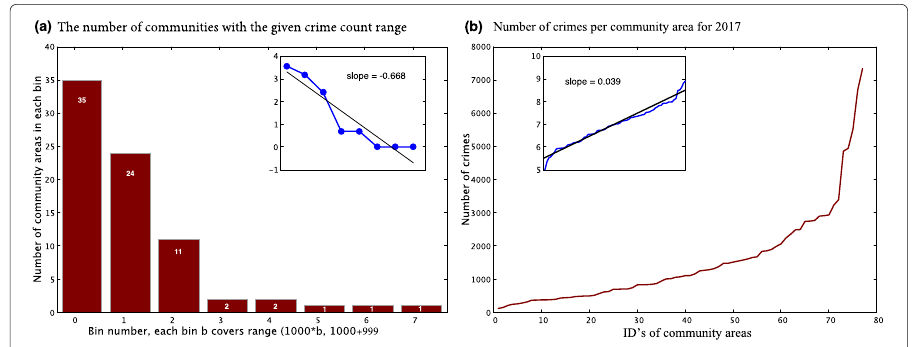
Fig. 2 Distribution of the number of crime incidents among communities. a Histogram of this distribution showing the number of areas within eight disjoint bins for the number of crime incidents, where range